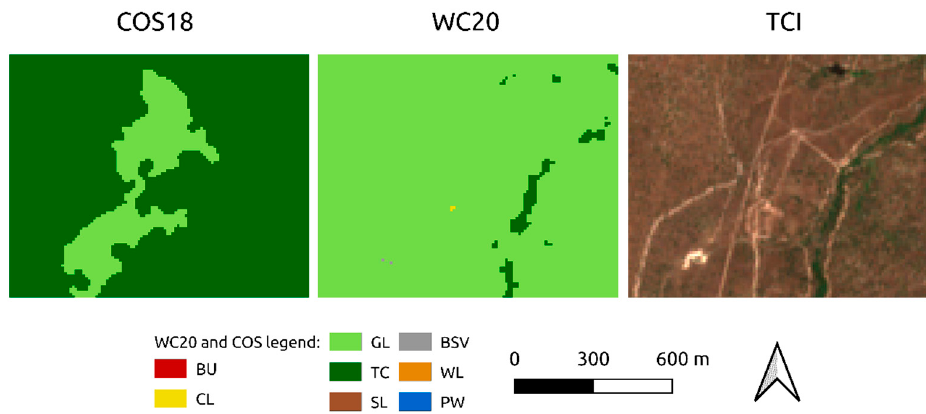
Figure 4. Example of ‘Agroforestry areas’ region with a central area covered in GL in COS18 and in WC20. TCI (true color image, Sentinel-2).